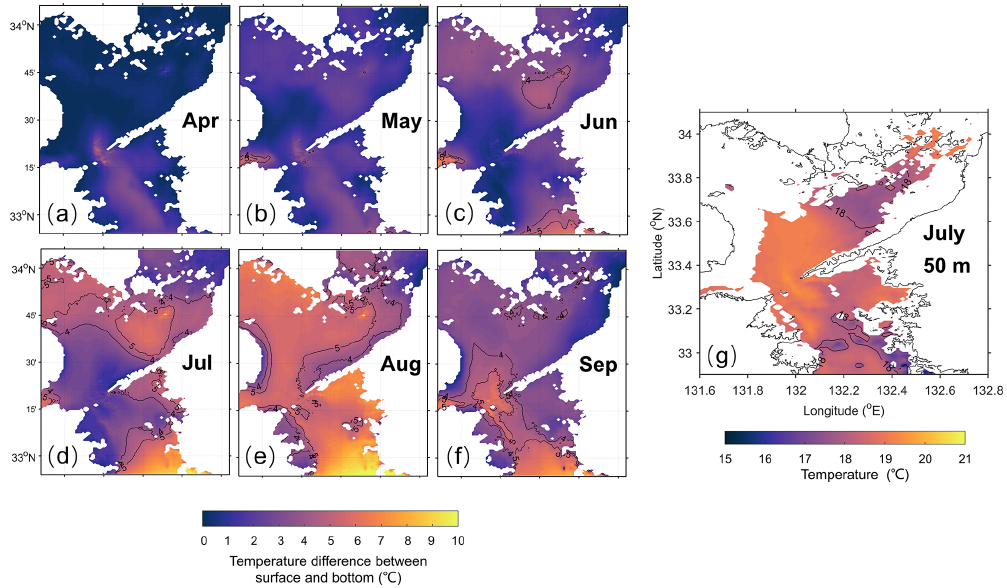
Figure 3. Simulated temperature differences between surface and bottom from April to September (a–f) and the spatial distribution of water temperature at 50m depth (g)